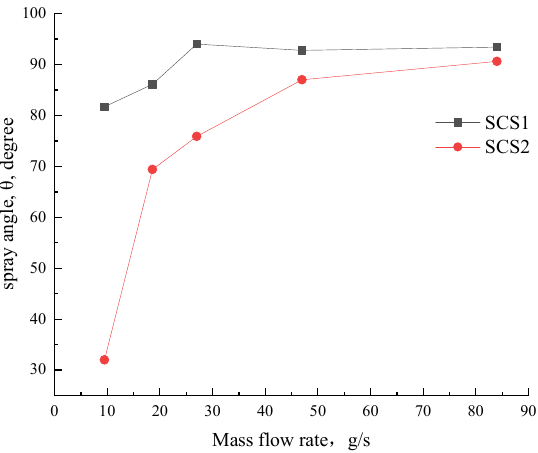
Figure 5. Change curve of spray angle with mass flow rate.